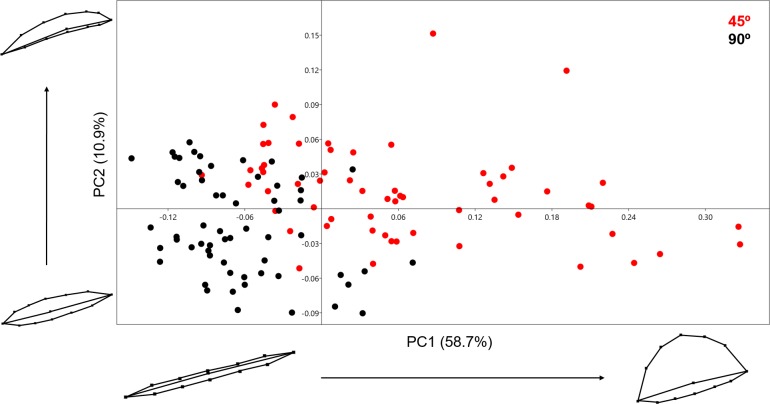
PCA graph presenting variance cut mark shape using the 13 landmark 3D model.Variance in shape is presented for the extremities of both PC scores along their respected axis.